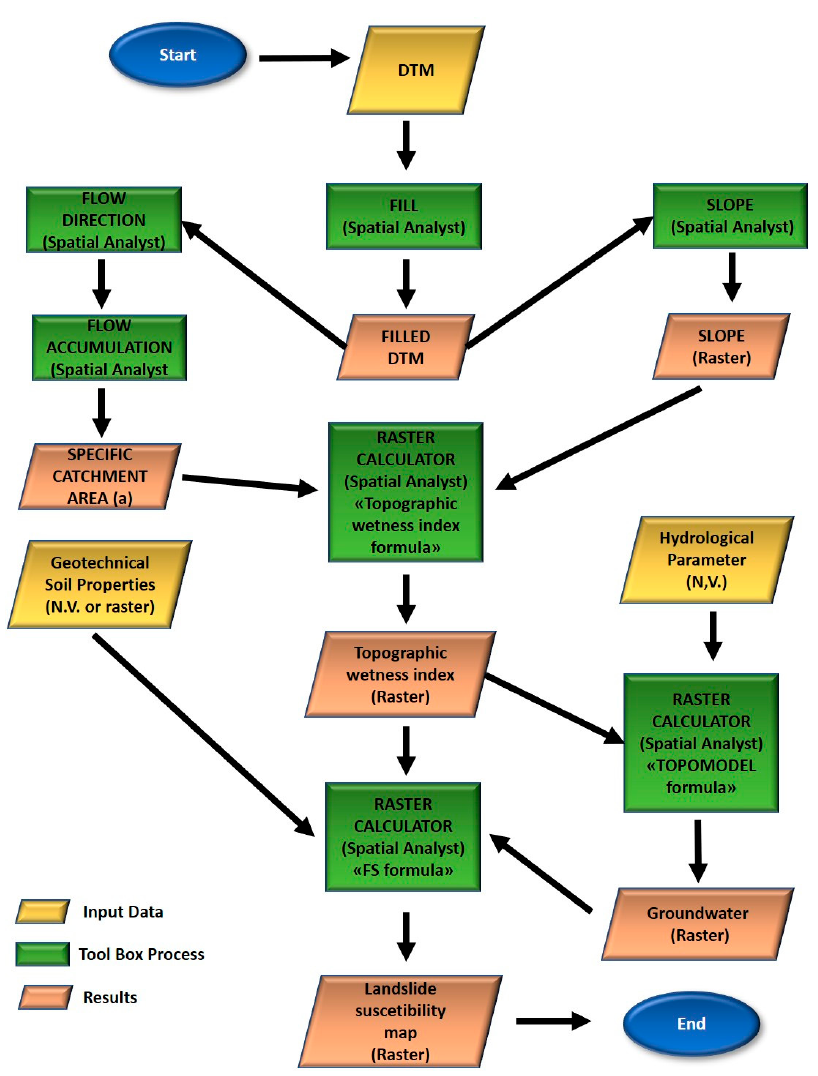
Figure 1. Data processing workflow as implemented in the Model Builder application.